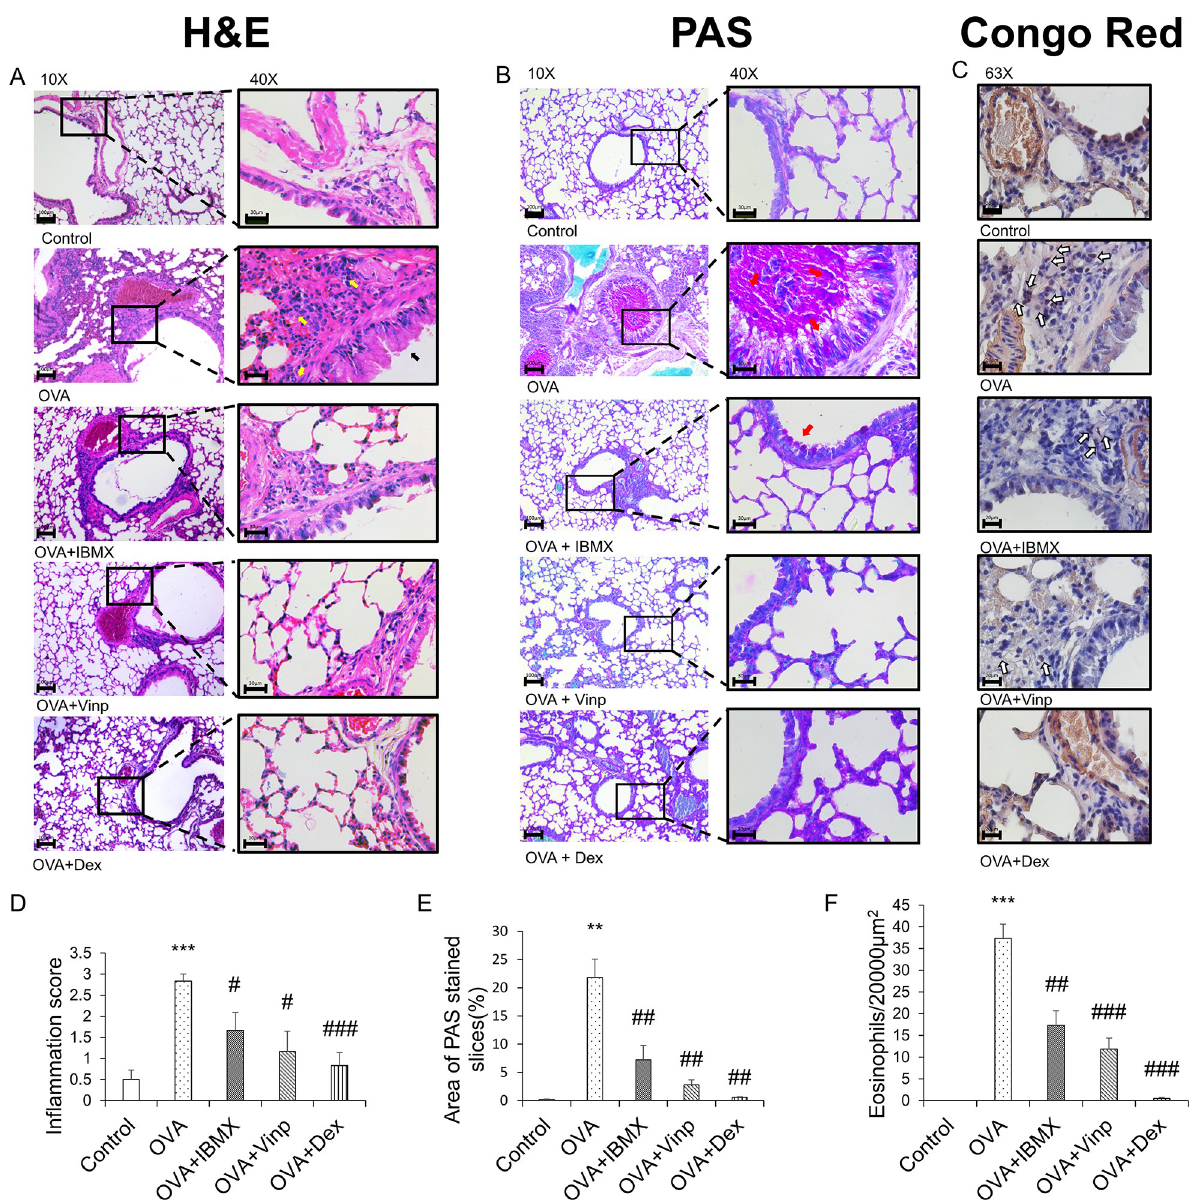
Fig 2. Inhibition of ovalbumin-induced histological changes by IBMX and Vinp. ( A ) H&E, ( B ) PAS, and ( C ) Congo red staining were performed to investigate the histological changes. H&E and PAS staining (left-hand side: magnification 10 × ; scale bar, 100 μ m; right-hand side: magnification 40 × ; scale bar, 30 μ m) show infiltration of inflammatory cells (yellow arrows), damage to epithelial cells (black arrows), and mucus stained magenta (red arrows). Congo red staining (magnification 63 × , scale bar, 20 μ m) shows the eosinophils (white arrows). ( D ) The inflammation scores were determined based on criteria. ( E ) PAS-stained areas were analyzed using ImageJ software. ( F ) Congo red-stained eosinophils were counted in a 20,000- μ m 2 area. Data are expressed as mean ± SEM. Statistical analysis was performed using one-way ANOVA (Data were considered significant at �� P < 0.01 and ��� P < 0.001 compared with the control group and # P < 0.05, ## P < 0.01, and ### P < 0.001 compared with the OVA group). IBMX, 3-isobutyl-1-methylxanthine; H&E, hematoxylin–eosin; PAS, periodic acid–Schiff; OVA, ovalbumin; Vinp, vinpocetine; Dex, dexamethasone. these effects slightly ( P < 0.05). Vinp also improved the morphological abnormality induced by OVA in the lungs ( P < 0.05). Mucus secretion (Fig 2B and 2E) and eosinophil recruitment in lung tissues (Fig 2C and 2F) were increased in the OVA group ( P < 0.01). IBMX and Vinp treatment reduced the mucus secretion compared with the OVA group ( P < 0.01) and